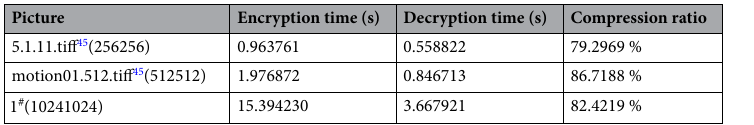
Table 6. Encryption time